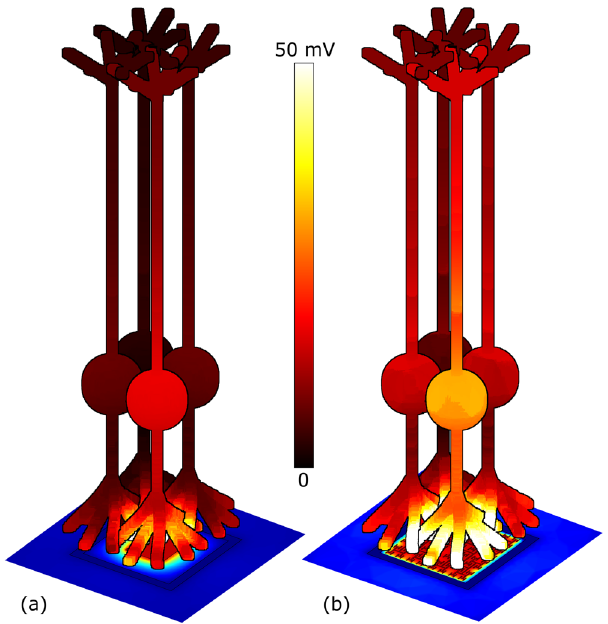
Figure 4. Plot of the maximum Δ V m (the change of potential across the membrane before and after stimulation) for a patch of bipolar neurons above ( a ) the square and ( b ) fractal electrodes both with V 0 = 0.2 V and f = 1 kHz. Maximum Δ V m within an oscillation is plotted to quantify the greatest stimulation achieved during a cycle. Plots of Δ V m throughout the electrode’s cycle are shown in Supplementary Fig. 3. For visual clarity, only 4 of the 9 neurons (center and 3 surrounding) are shown. Images are drawn to scale; the neurons are 100 µ m in length and the soma is centered 30 µ m above the